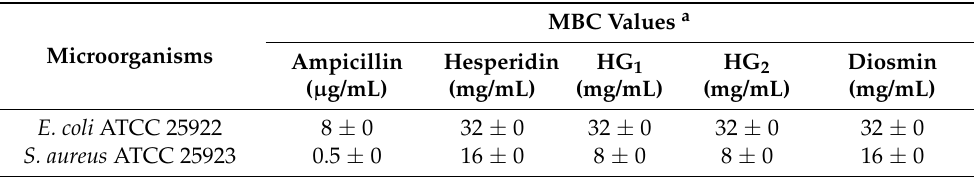
Table 3. Minimal bactericidal concentration (MBC) of hesperidin glycosides, diosmin, and standard drug.